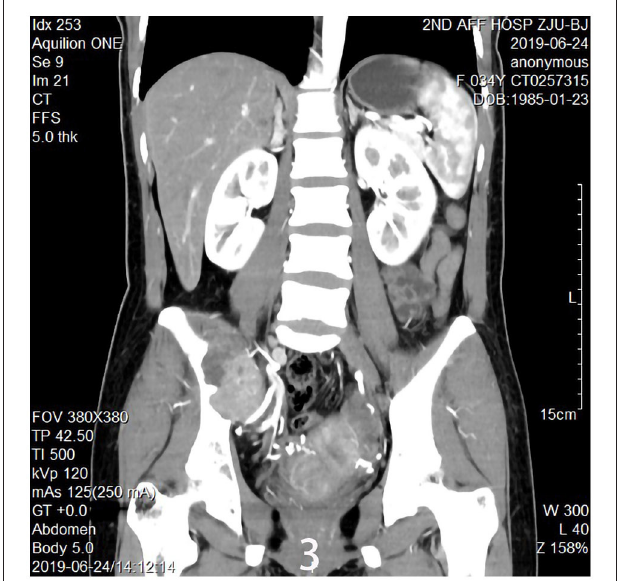
FIGURE 3 | Imaging of the abdominal aorta shows the blood supply of the lesion came from the internal iliac artery.